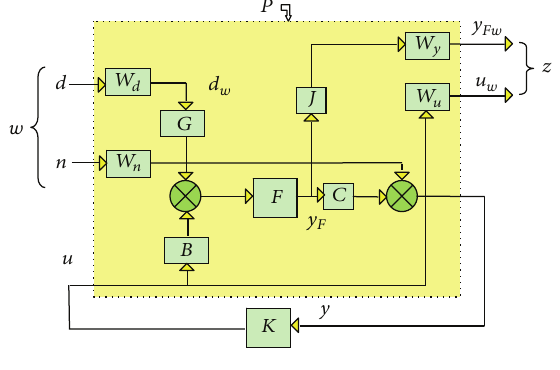
Figure 9: Details of 𝐻 ∞